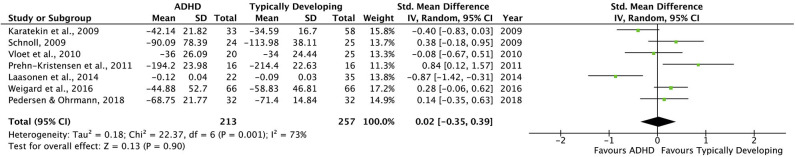
Forest Plot showing study weighted effect sizes (SMD) and overall effect size for all comparisons. Study level group means represent degree of sequence learning as the mean difference in RT between the final random block and preceding sequence block on the SRT task. Positive SMD values indicate greater sequnce learning in TD groups, whereas negative SMD values indicate greater sequence learning in ADHD groups.